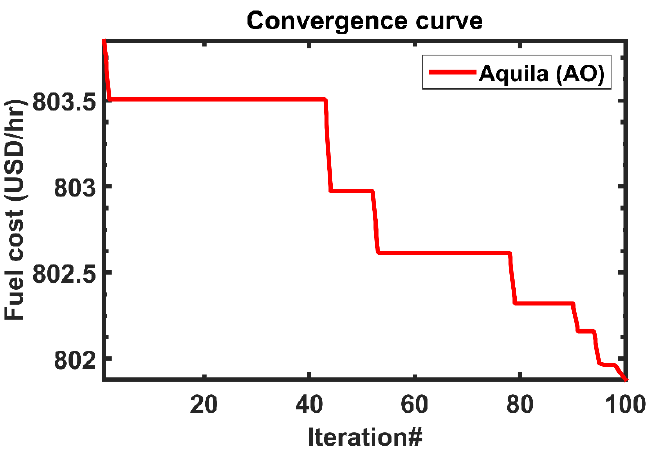
Figure 5. Convergence curve for IEEE-30 bus system using AO.